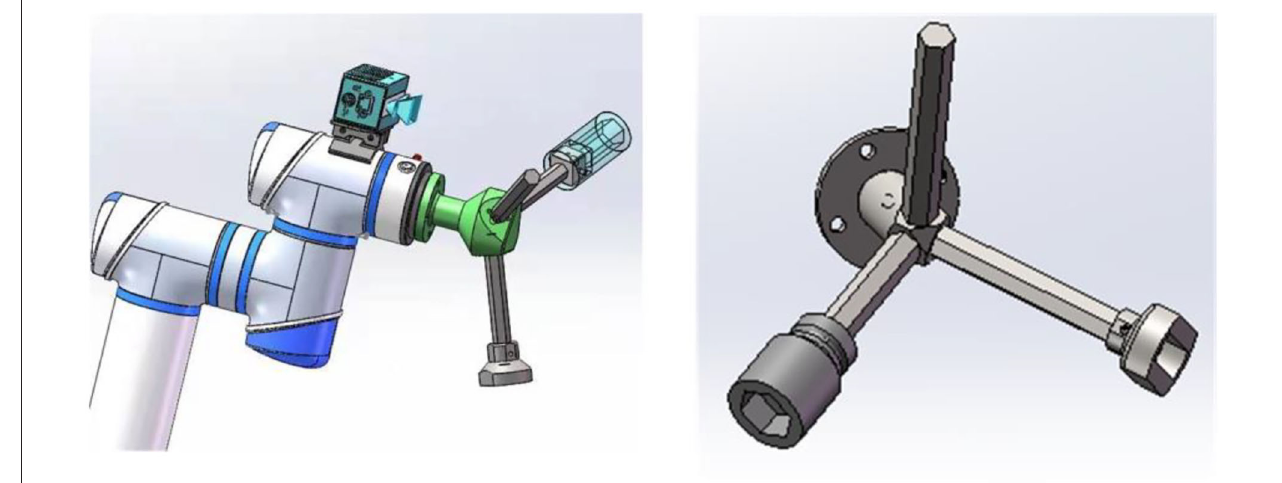
FIGURE 8 | Multipurpose tool installed at the robot’s end effector.